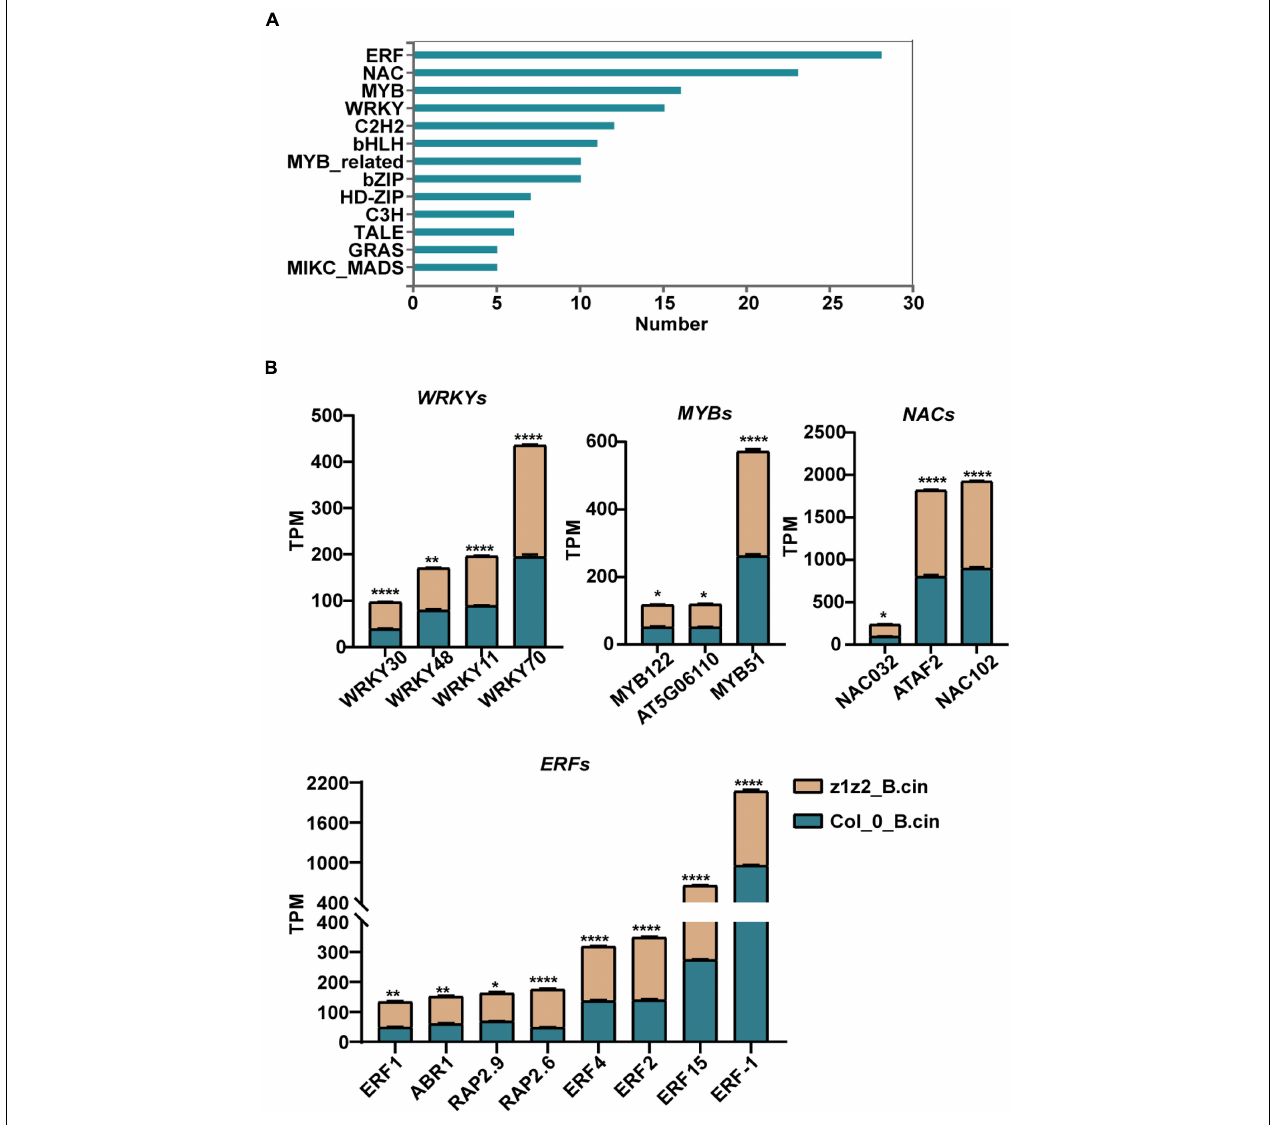
FIGURE 5 | Gene Ontology (GO) analyses of differentially expressed transcription factor genes between zar1-3zar2-1 and Col-0 plants upon B. cinerea infection. (A) Top 10 enriched clusters (GO analysis) of transcription factors genes based on data of the differentially expressed genes between Col-0 ( B. cinerea treatment) and zar1-3 zar2 ( B. cinerea treatment) detected in the RNA-sequencing. (B) TPM (transcripts per Million) value of four defense-related transcription factor gene subgroups ( WRKYs , MYBs , NACs , and ERFs ) derived from the differentially expressed genes between Col-0 and zar1-3zar2-1 mutant after B. cinerea infection. Asterisks indicate significant differences between zar1-3zar2-1 mutant and Col-0 plant (* P < 0.05, ** P < 0.01, **** P < 0.0001, Student’s t